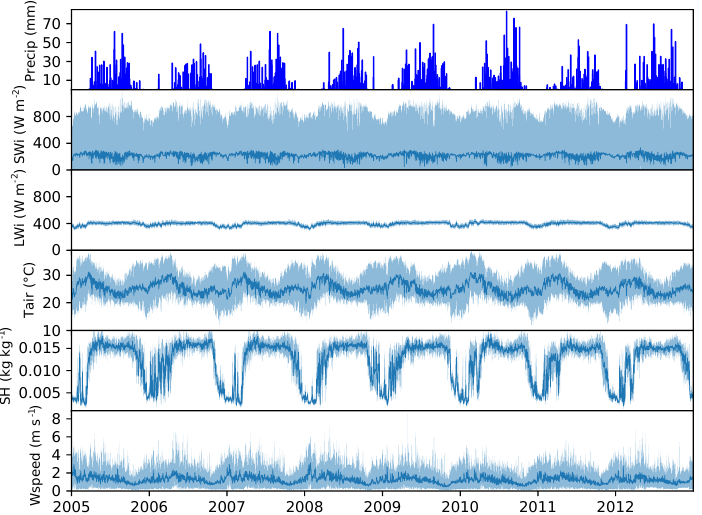
Figure 2. Model forcing. Upper panel: daily precipitation. SW in : incoming short waves, LW in : incoming long waves, T a : air temperature, SH: specific humidity, wind spd: wind speed. Data are shown as the daily mean (black curve) and daily minima and maxima (shaded